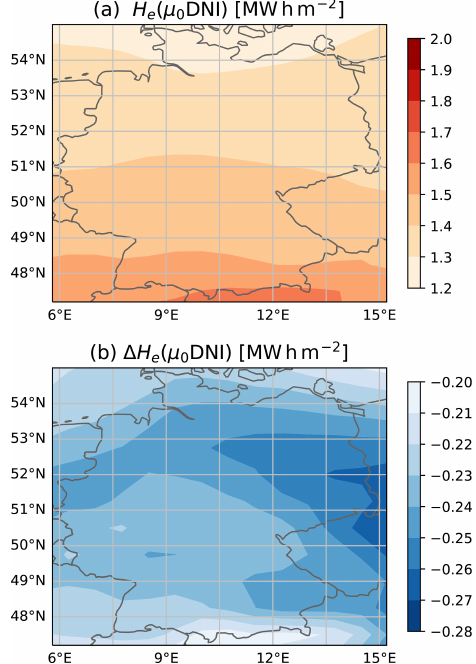
Figure D8. Annual radiant exposure ( H e = (cid:82) µ 0 F DNI d t ) from µ 0 DNI assuming cloud-free conditions (a) and reduction due to aerosols ( (cid:49)H e = H e − H e, pri , b ) at the surface over Germany in 2015. The calculation is conducted with the T–CARS